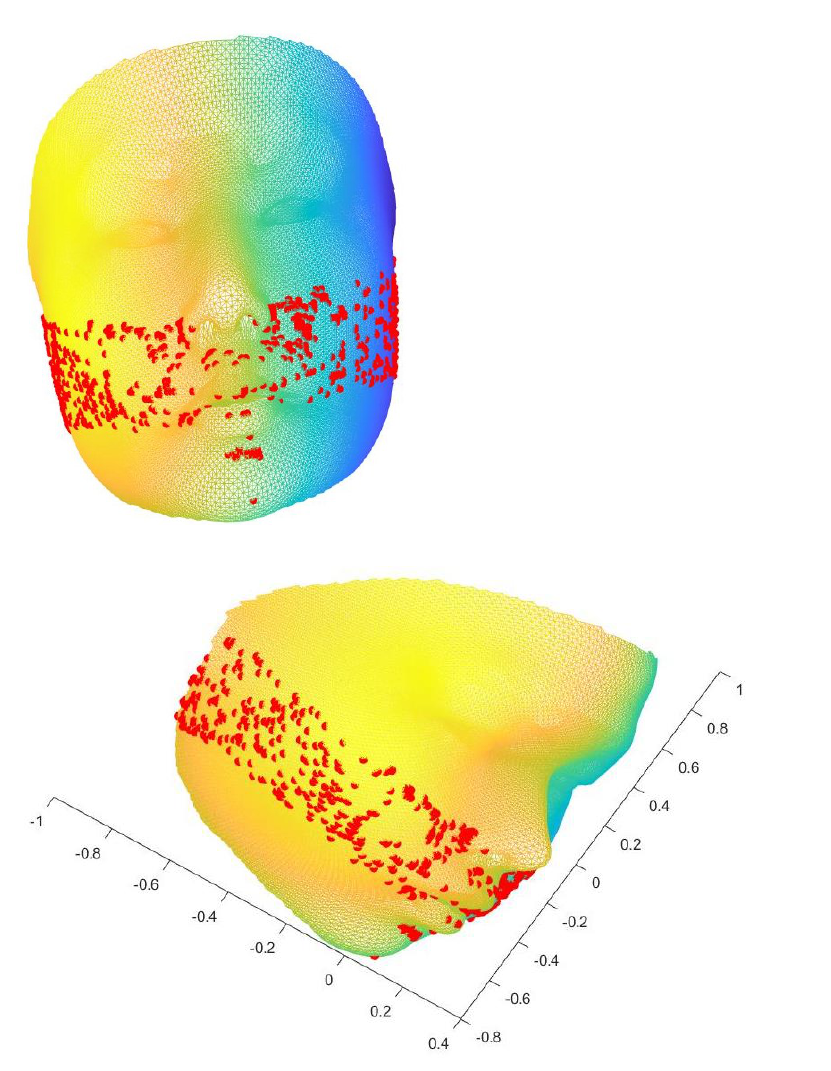
Figure 4. Landmarks having high classification power chosen by the bagging